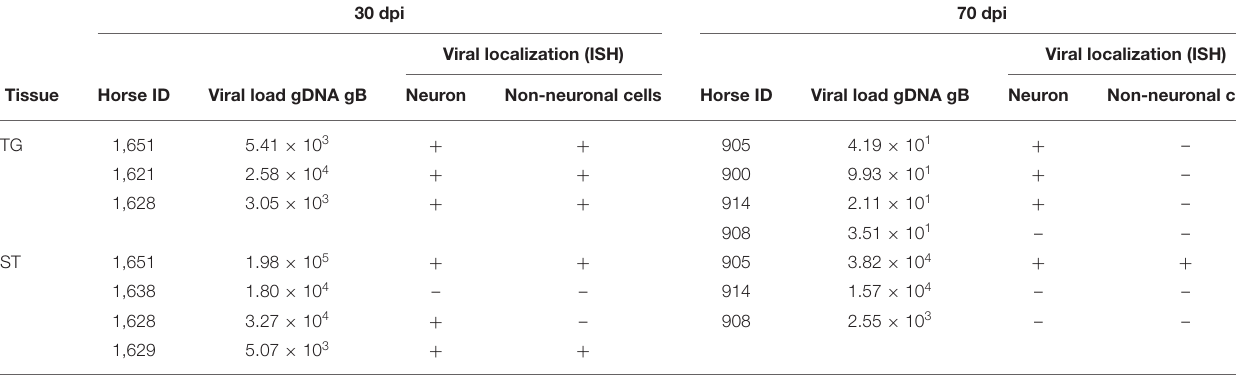
TABLE 3 | Cellular visualization of EHV-1 DNA in trigeminal ganglia and sympathetic trunk ganglia using in situ hybridization. 30 dpi 70 dpi Viral localization (ISH) Viral localization (ISH) Tissue Horse